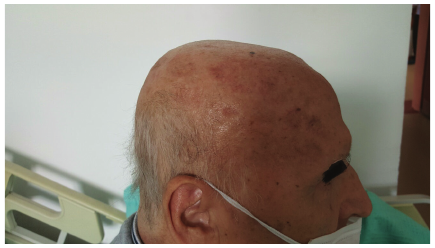
Figure 2: After salvage